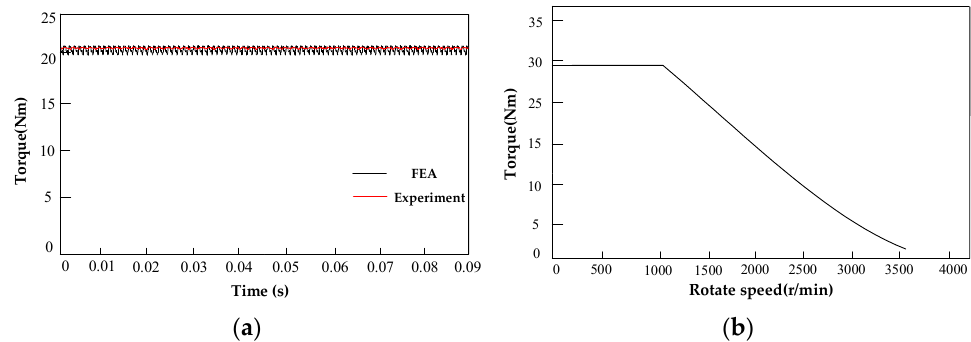
Figure 19. ( a ) Measured and simulated torque; ( b ) The torque–speed curve of the machine.